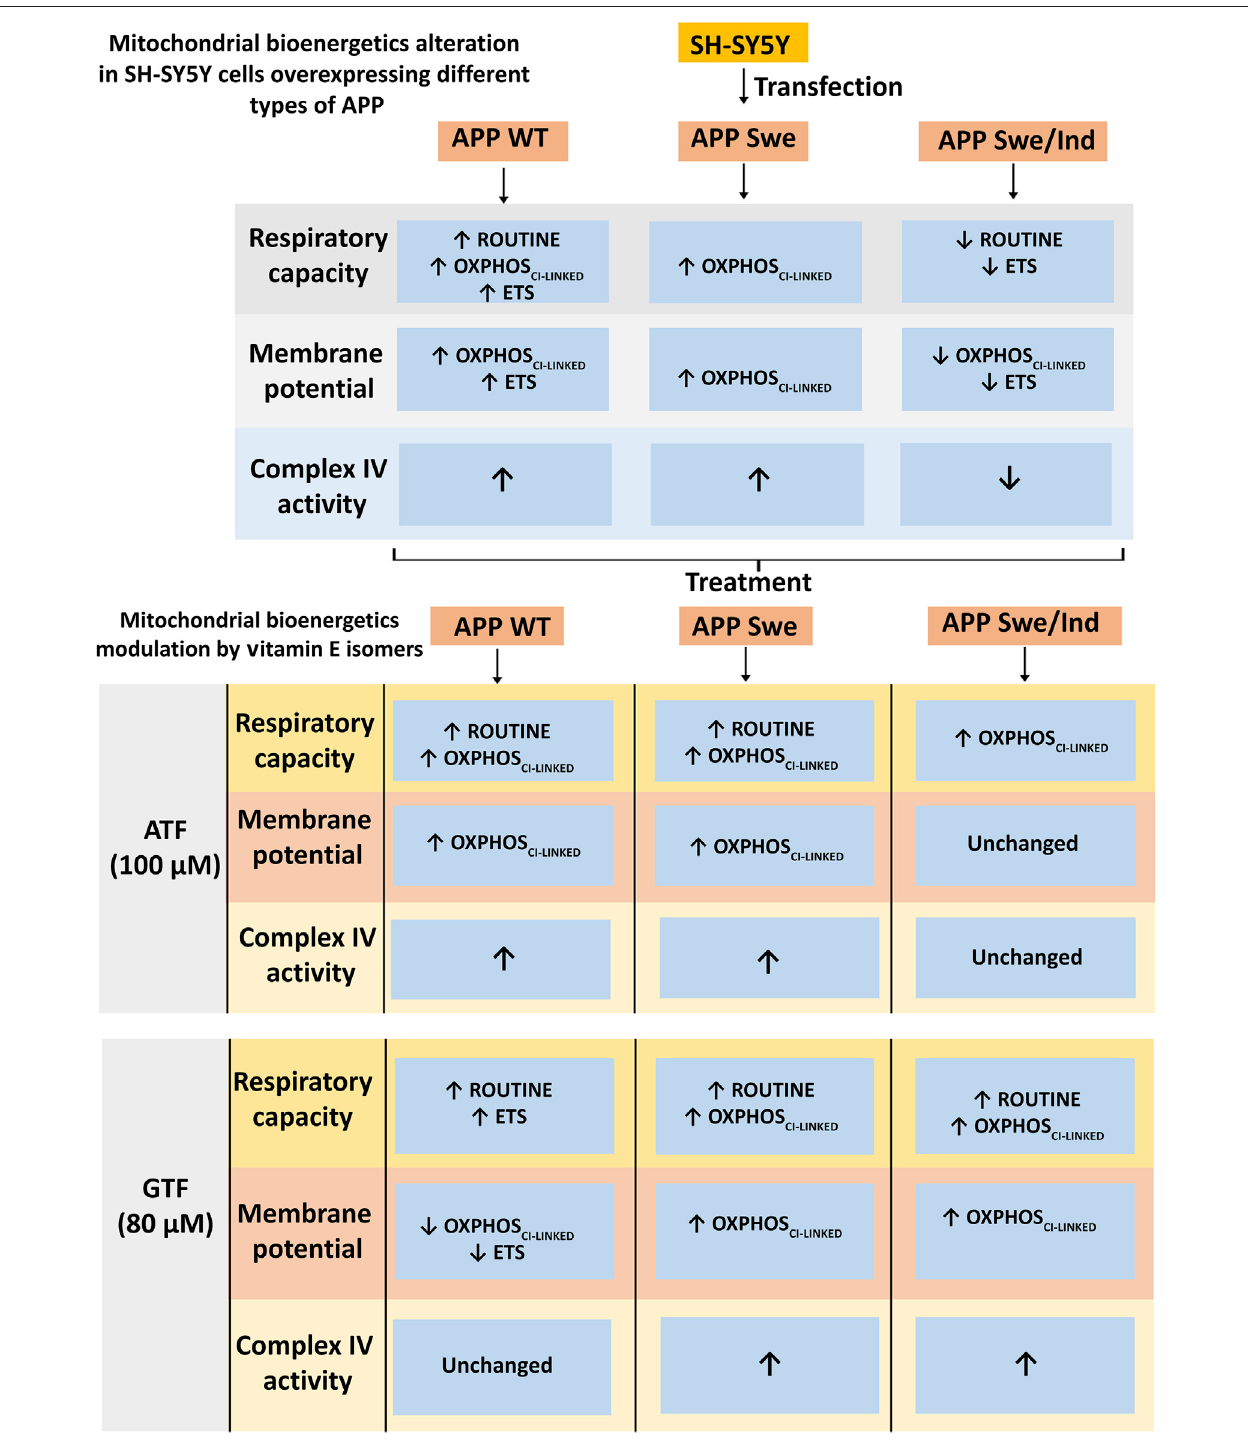
FIGURE 5 | Schematic diagram of mitochondrial bioenergetics alteration in SH-SY5Y cells overexpressing different types of APP and modulation by vitamin E isomers. The APP WT and Swe overexpressing cells showed increased in mitochondrial bioenergetics at OXPHOS CI-LINKED state accompanied by an increased in complex IV enzyme activity whereas the APP Swe/Ind overexpressing cells showed decreased in mitochondrial bioenergetics at ETS state followed by a decreased in complex IV enzyme activity. ATF and GTF modulated mitochondrial bioenergetics differently in different types of APP overexpressing cells generally by increasing the respiratory capacity, membrane potential and complex IV enzyme activity.